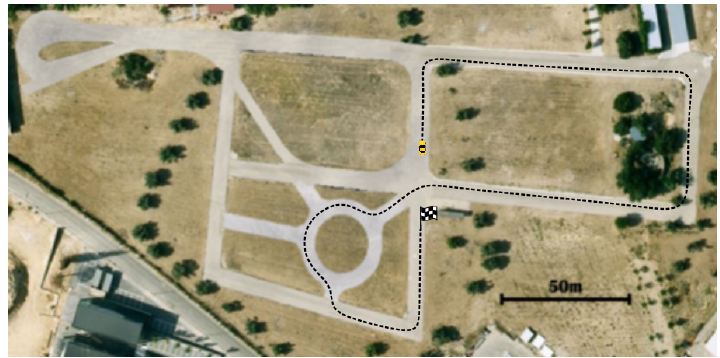
Figure 21. Route to be followed in the experiments with real